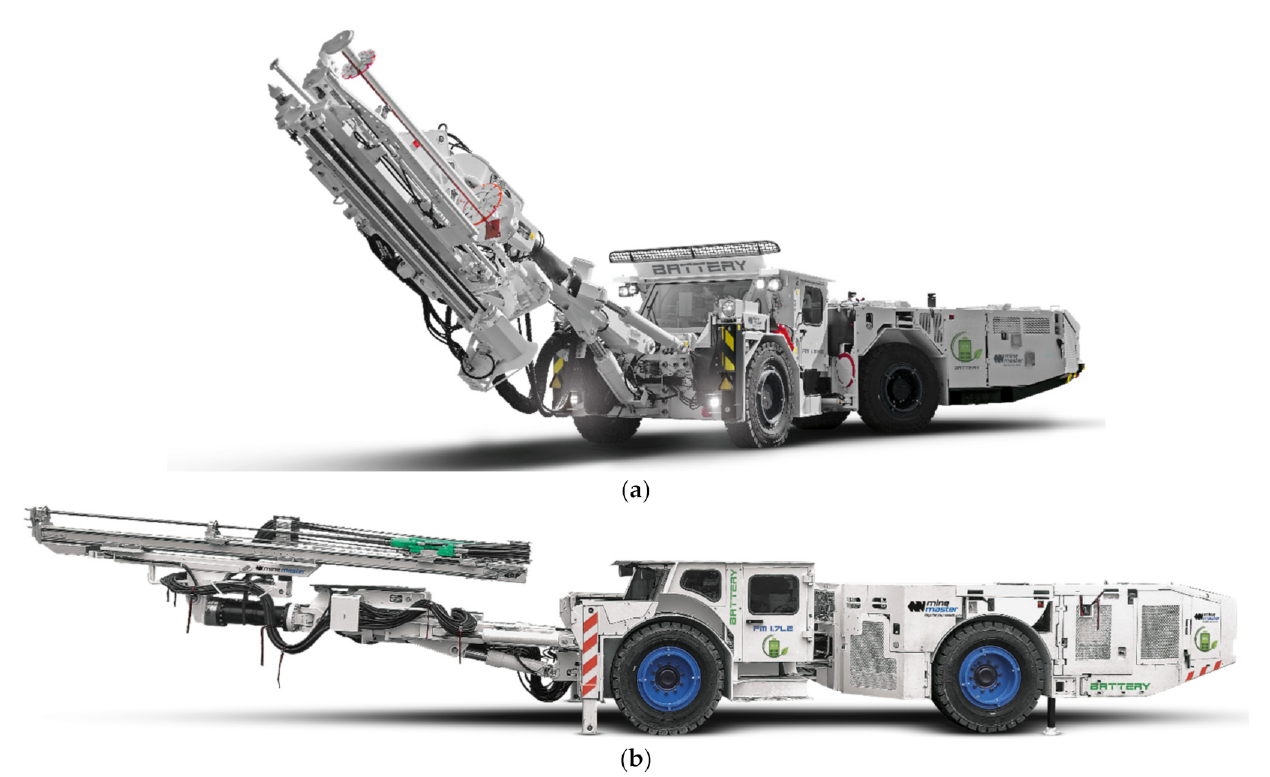
Figure 1. Mine Master battery-powered electric self-propelled mining machines: ( a ) Roof Master RM 1.8KE bolting rig, ( b ) Face Master FM 1.7LE drilling